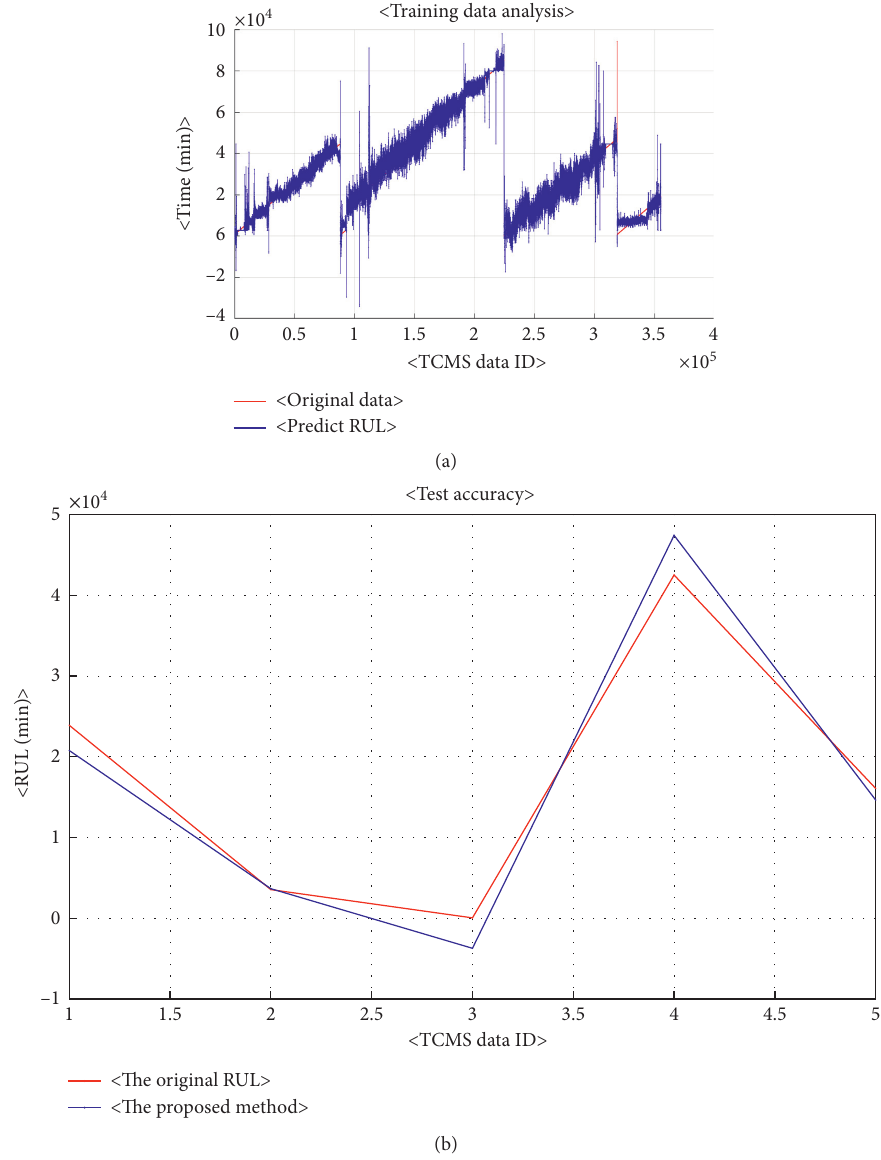
Figure 6: The training and the test accuracies of the proposed RUL prediction (for fault code ID 31). (a) The training accuracy. (b) The test